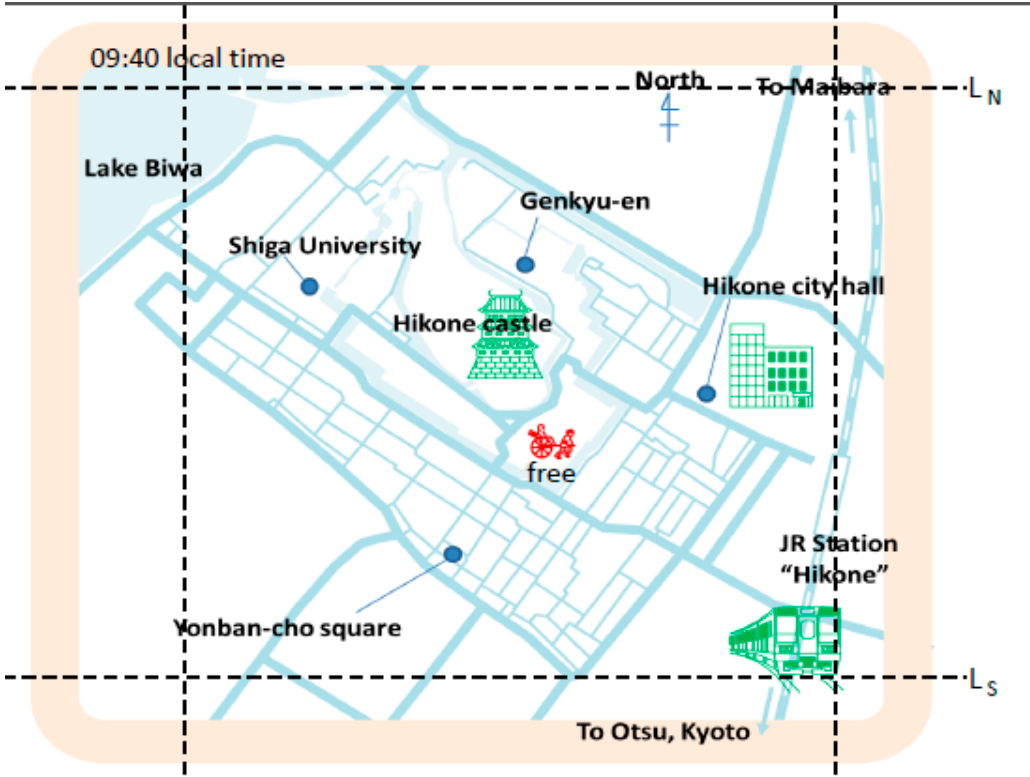
Figure 2. Information displayed in mobile device shown in Figure 1a [37]. Rickshaw location shown in red is visible on the geographical map as open data on the internet. Detailed geographical meshes used in this study are shown in the Appendix (Figure A1). L N (35.282095 deg.), L S (35.266204 deg.), L E (136.263345 deg.), and L W (136.242744 deg.) indicate area boundary lines for data analysis, defined